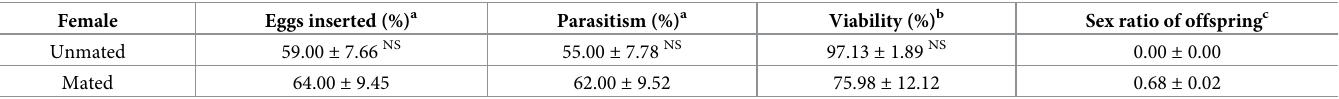
Significant differences as determined by the unpaired t-test ( a ) or Mann-Whitney U test ( b ) are indicated with � (p < 0.05) and not significant differences with NS. ( c ): Treatments not analyzed, because there is no variation among unmated data (only male